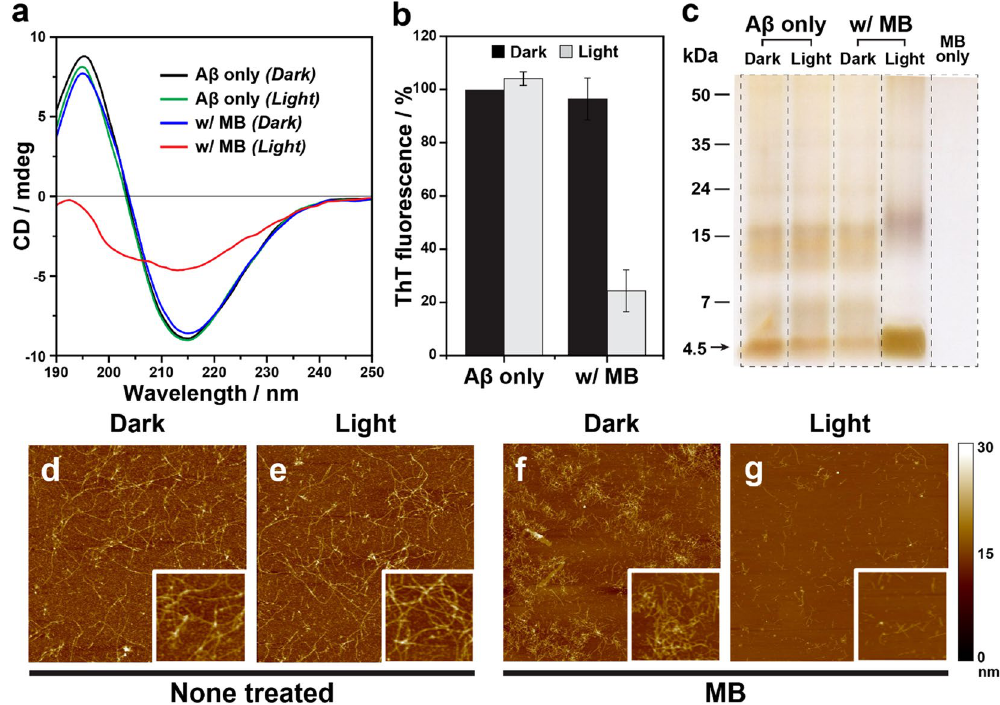
Figure 2. Light-induced suppression of A β 42 self-assembly by MB. ( a ) CD spectra of A β 42 aggregates incubated under various conditions. Two characteristic peaks in the CD spectrum presenting the β -sheet structure disappeared in the MB (10 μ M)-treated A β 42 (40 μ M) under light illumination. ( b ) ThT fluorescence assay to measure the formation of amyloid fibrils. Significant decrease in ThT fluorescence indicates that the aggregation of A β 42 monomers was substantially suppressed. ( c ) Silver-stained native gel electrophoresis showing that the monomeric contents was highly increased in MB-treated A β 42 under light illumination. The arrow indicates a 4.5 kDa molecular mass that corresponds to the monomers of A β 42 . ( d–g ) Representative AFM images of A β 42 incubated with or without MB under dark and light conditions. Only fragmented fibrils were observed in MB- treated A β 42 (see insets enlarged from